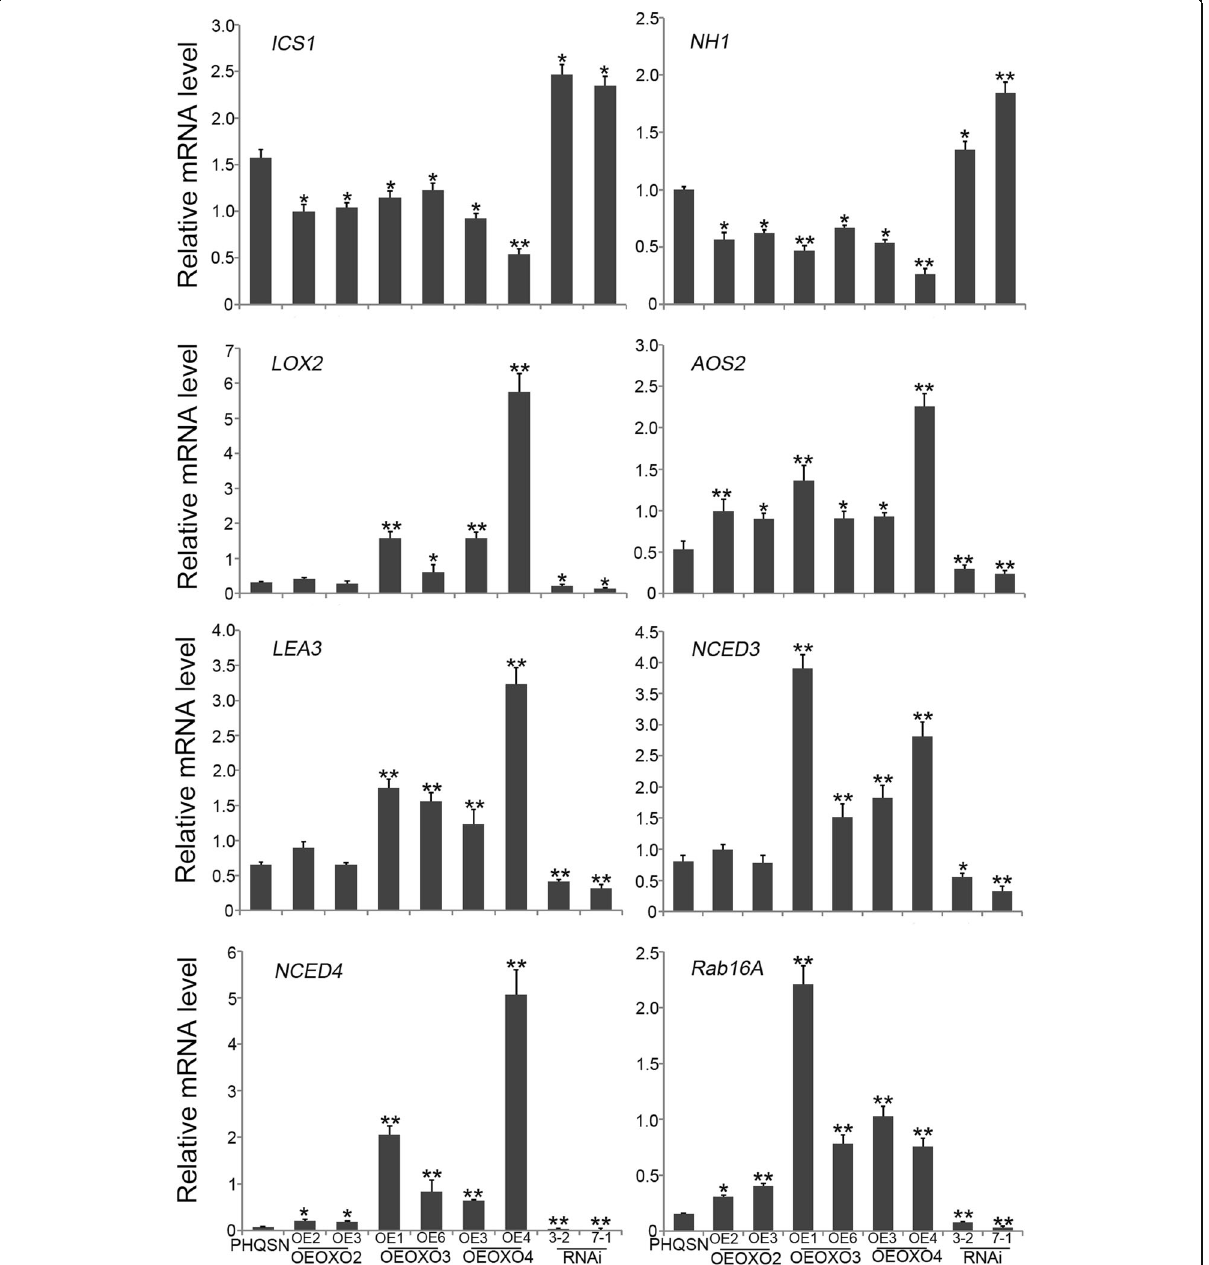
Fig. 7 The expression of plant hormone related genes in panicles of the OXO transgenic plants and control plants by quantitative RT-PCR. Error bars indicate the SD from three biological replicates and asterisks indicate statistically significant differences compared to the control plants ( t test, ** P < 0.01 and * P <